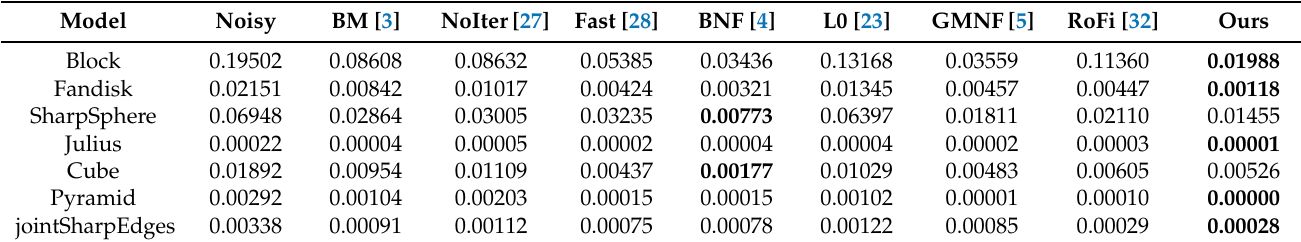
Table 4. The average distance D mean from the resulting mesh vertices to the ground-truth mesh surface. The lowest value per row is highlighted in bold.